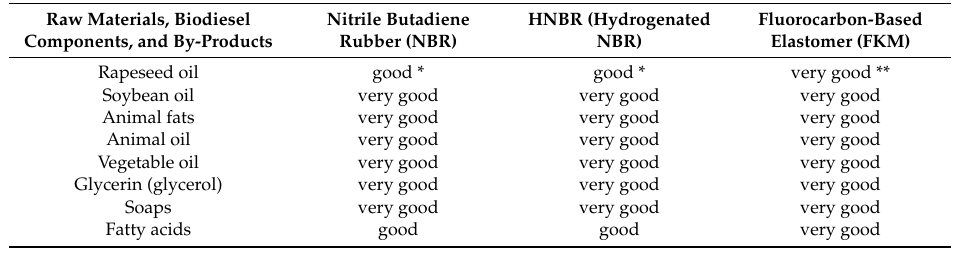
Table 1. Elastomer materials compatibility with di ff erent types of biodiesel raw materials, components, and by-products.